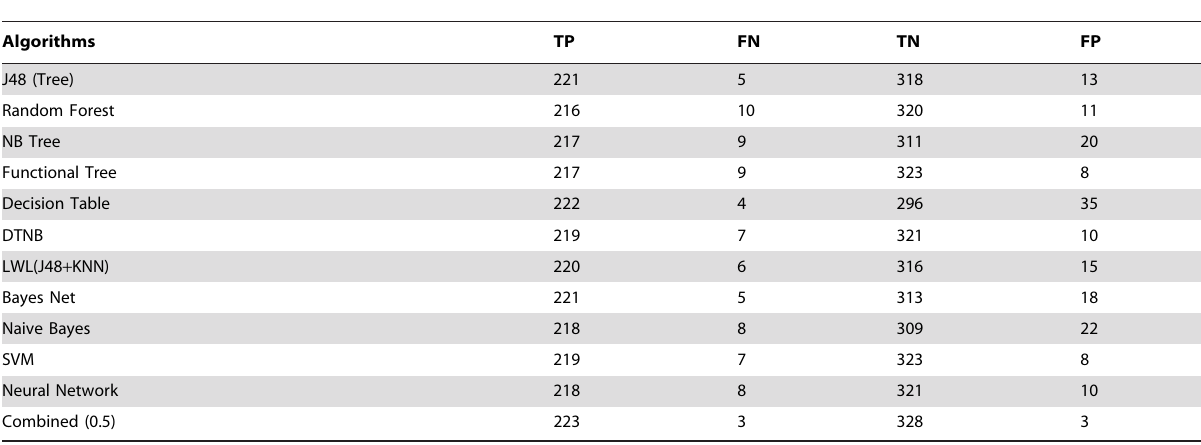
Table 2. Confusion matrix of individual classifier performance.